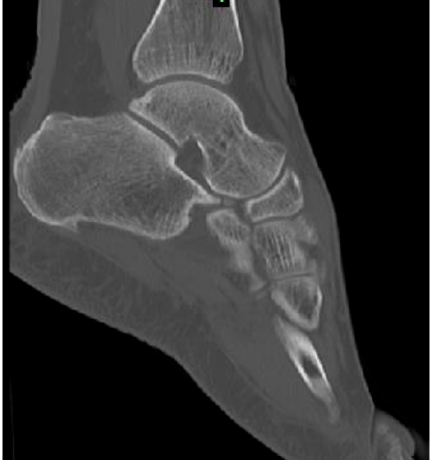
Figure 6. CT image of the foot–sagittal plane.